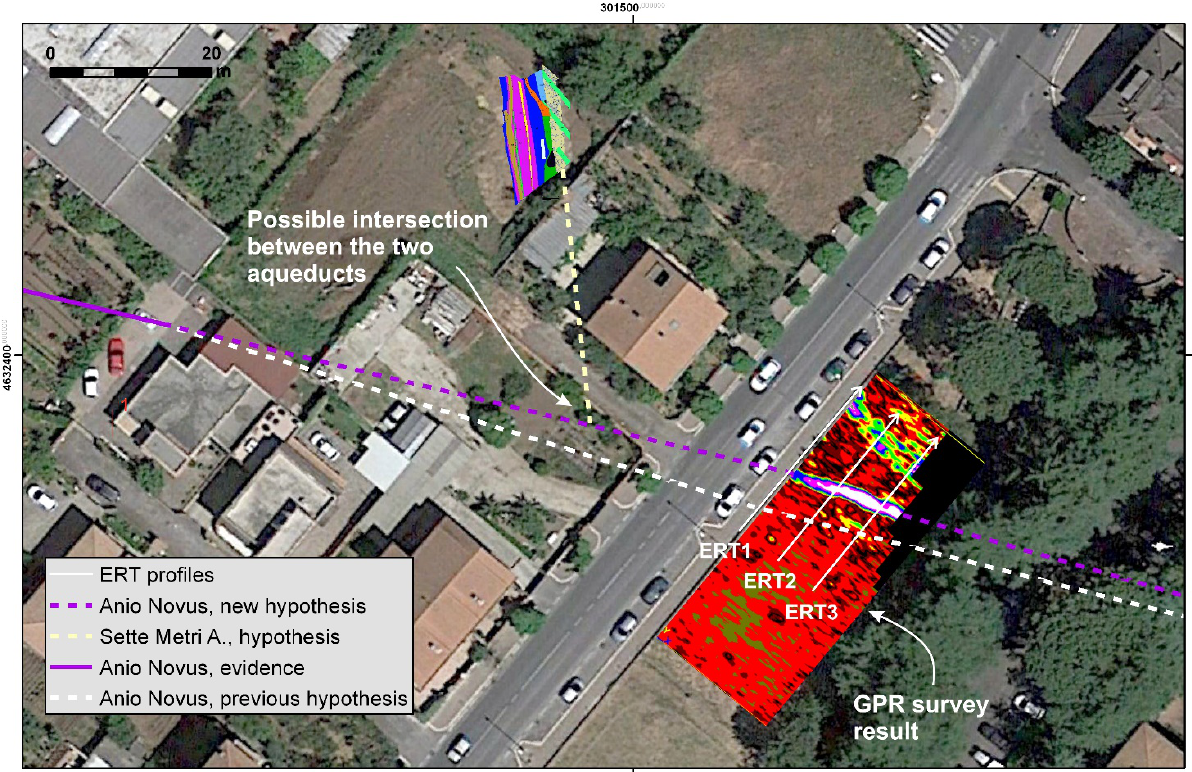
Figure 8 . The possible intersection point between the Anio Novus and the Sette Metri aqueduct estimated on the base of archaeological and geophysical